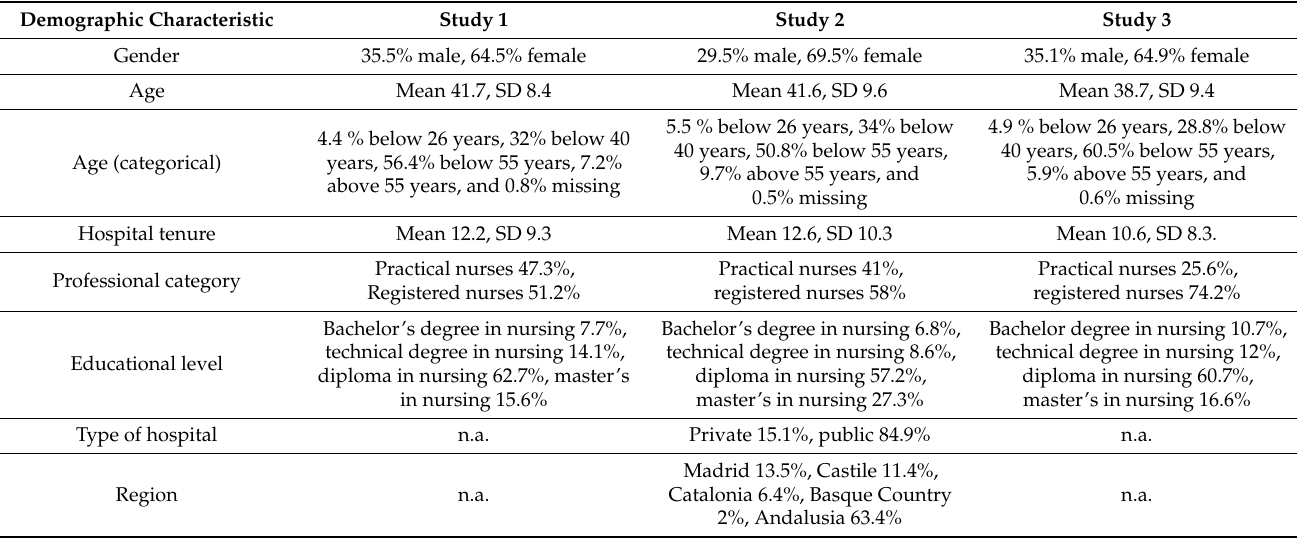
Table 1. Demographic characteristics of